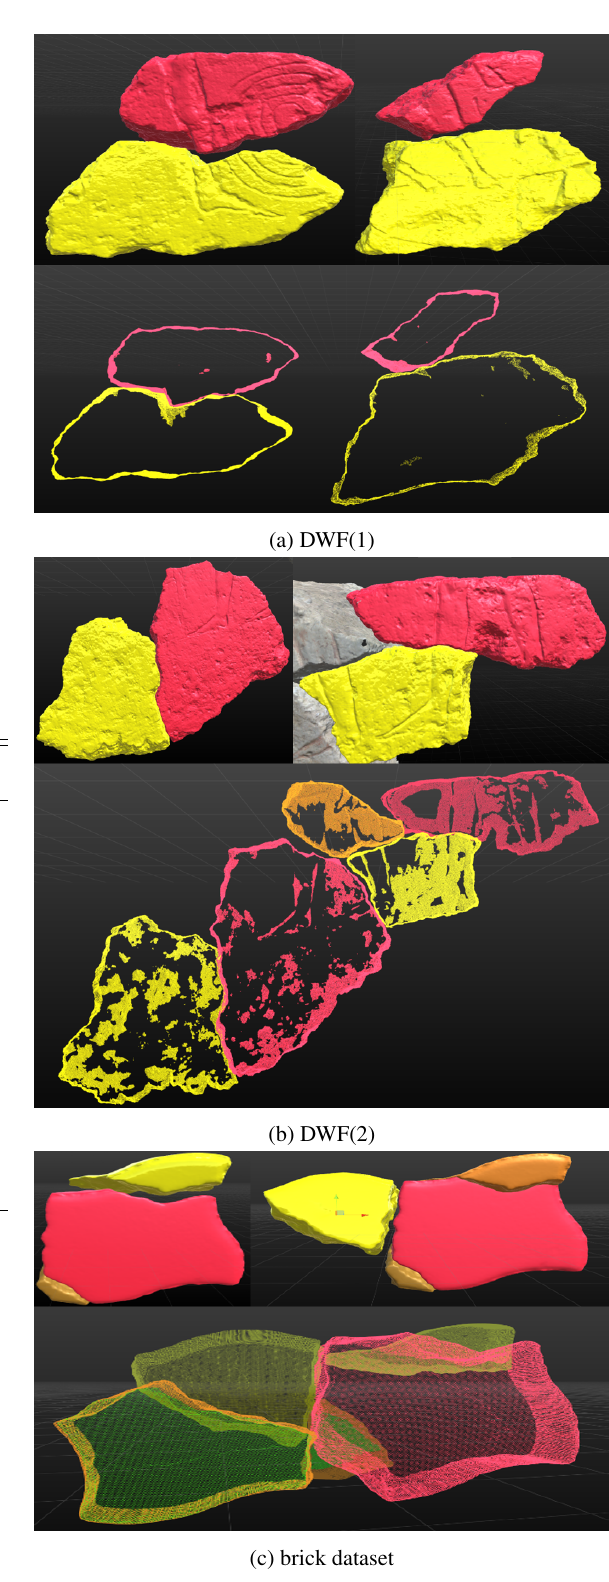
Figure 6: Rough Alignments for Table 3 (top images). Point- clouds of contour surfaces after fine alignment (button